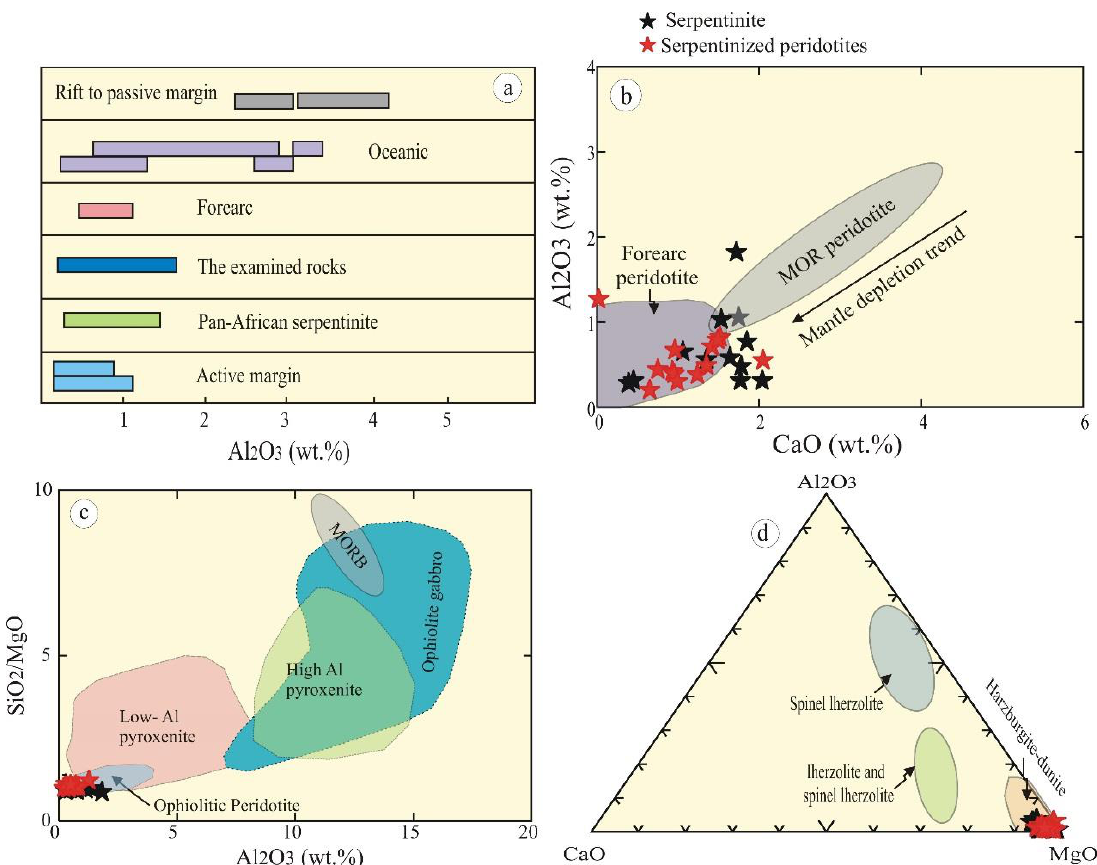
Figure 8. ( a ) Al 2 O 3 of the examined rocks compared to Pan-African serpentinites [22] and others from [48]; ( b ) CaO vs. Al 2 O 3 of bulk rock [49]; ( c ) Al 2 O 3 vs. SiO 2 /MgO diagram [45]; and ( d ) CaO-Al 2 O 3 -MgO ternary diagram [50]. The incompatible trace elements of the examined mantle rocks are depleted in high- field-strength elements (HFSEs)—such as Zr (0.52–2.75 ppm), Hf (0.0.1–1.89 ppm), Nb (0.37– 3.12 ppm), and Ta (0.17–1.36 ppm)—and low-field-strength elements (LFSEs), including Rb (0.19–1.85 ppm), Ba (3–10 ppm), and Sr (2.34–5.91 ppm) (Table 2). Multiple